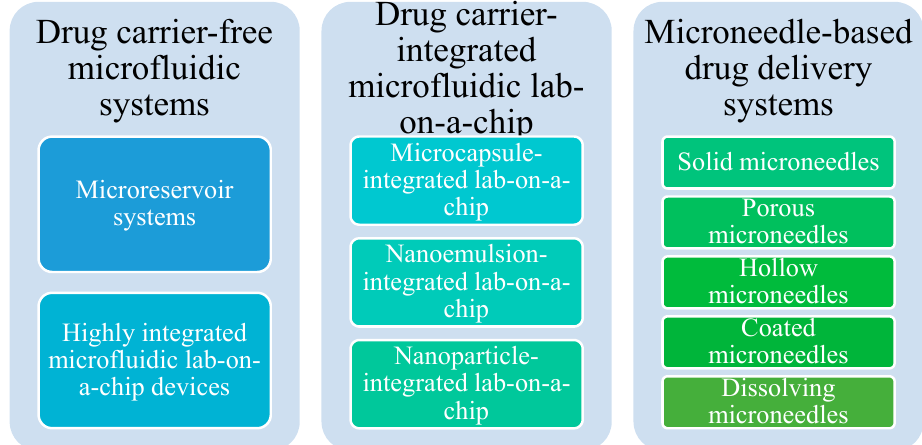
Figure 6. Microfluidic drug delivery systems classifications. Created based on information from a literature reference [105].